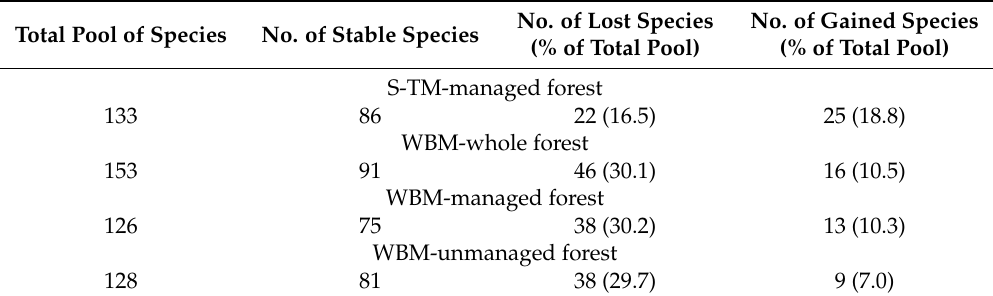
Table 1. A comparison of the species pool of the two surveys in the Sanocko-Turczanskie Mountains